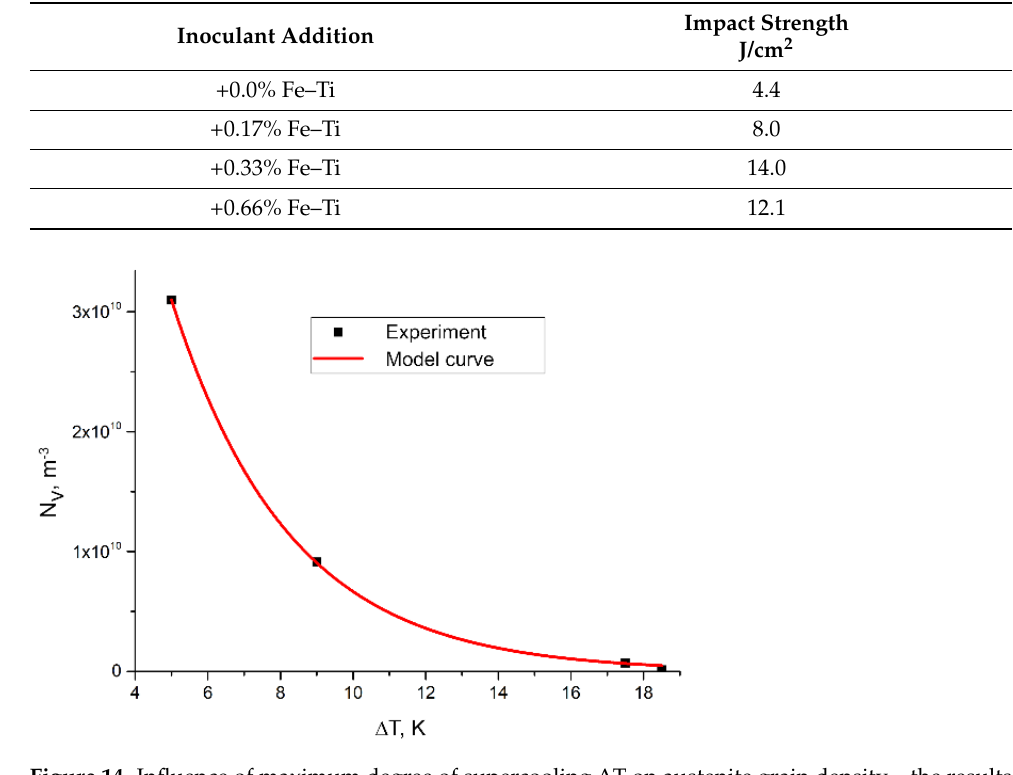
Table 3. Impact strength of the tested cast iron samples.